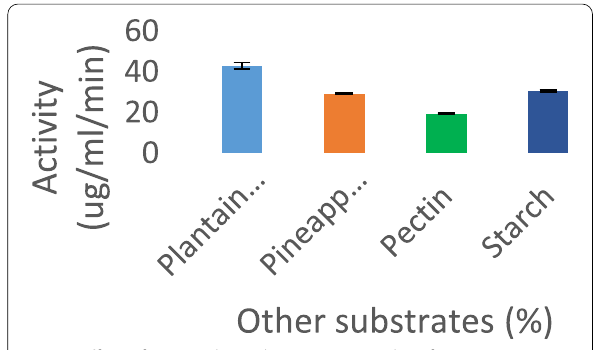
Fig. 5 Effect of using other substrates on Amylase from P.